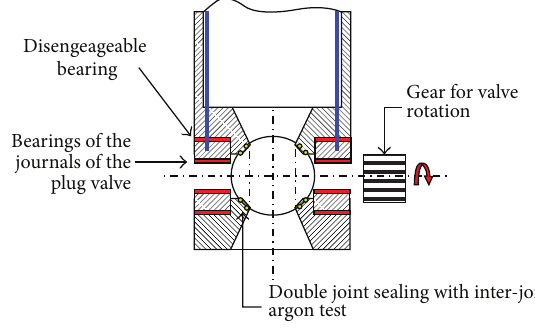
Figure 17: Plug valve at the bottom of the